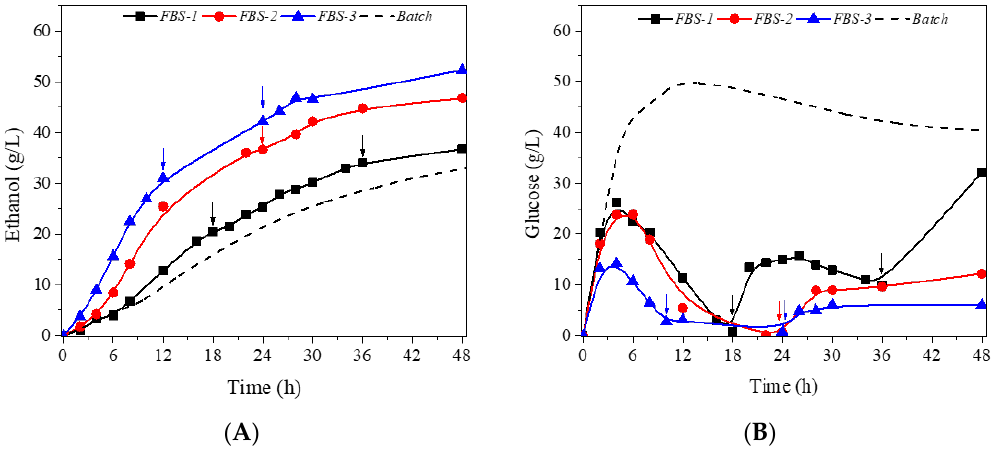
Figure 4. Ethanol ( A ) and glucose ( B ) concentrations from different strategies of fed-batch SSF at 24% ( w / v ) solid loading. Dotted line represents the batch SSF experiment at 24% ( w / v ) solids and the arrows above the curves indicates the substrate feed time for each strategy.